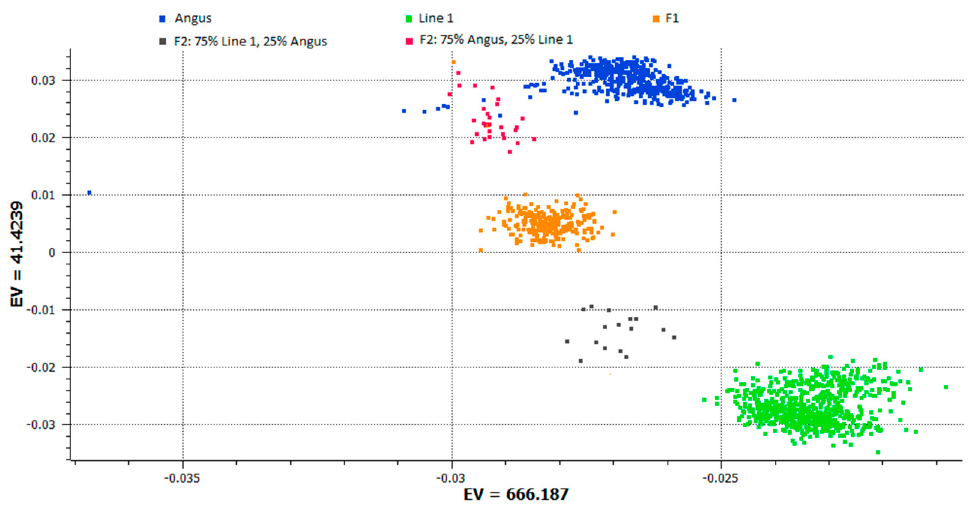
Figure 1 . Principal component analysis plot showing the distribution of animals using the first two principal components of the genomic relationship matrix.